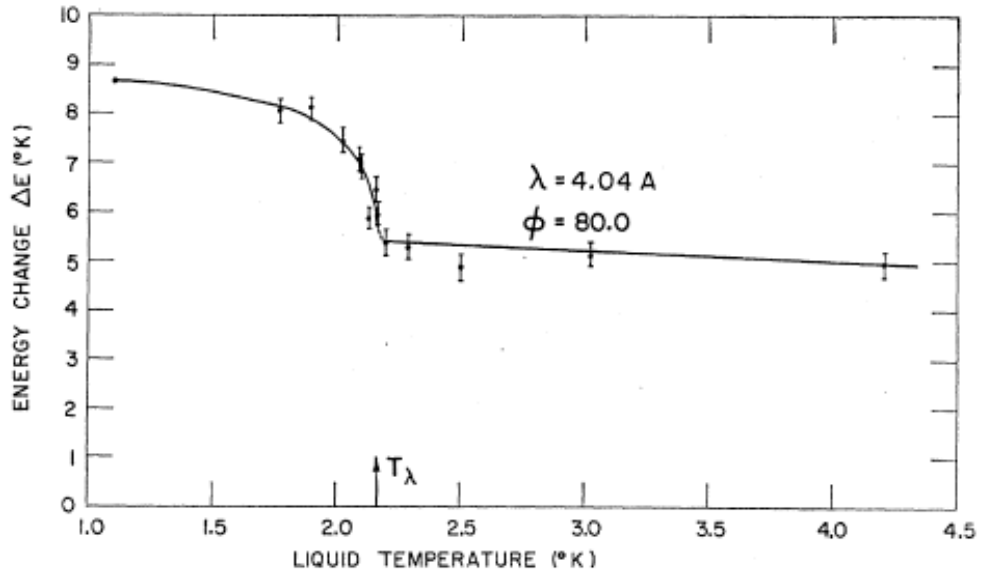
Figure 42. The temperature variation of the mean energy change of 4.04 Å neutrons scattered through 80° from liquid helium. This corresponds closely to the energy of the elementary excitation at the Landau roton minimum. The smooth curve is drawn through the points as a guide to the eye. This figure is taken from Figure 6 of ref. [100]. Copyright by the American Physical Society.